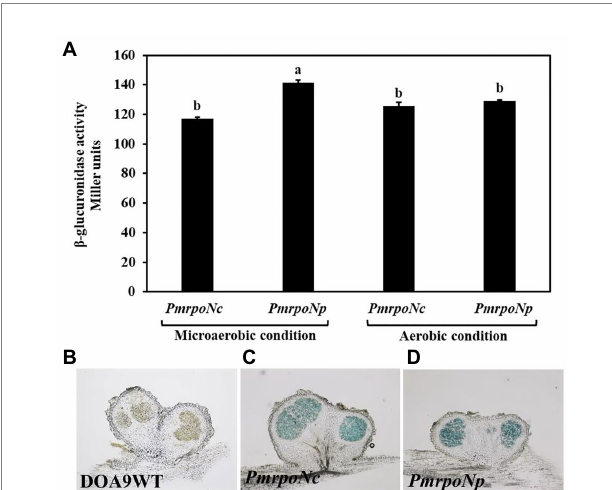
FIGURE 2 Expression of chromosomal and plasmid encoded rpoN under free- living and symbiotic conditions. PmrpoNc and PmrpoNp GusA reporter strains were grown under microaerobic and aerobic conditions and after 7 days of incubation, and β -glucuronidase activity (in Miller units) was determined. Data sets represent mean values of five replications, and statistically significant differences (ANOVA Tukey test; p < 0.01) are indicated (A) . β -glucuronidase activity in nodules of Aeschynomene americana plants inoculated with the WT and PmrpoNc and PmrpoNp GusA reporter strains at 14 dpi (B–D) . β -glucuronidase activity in nodule slices was determined by staining with X-gluc for 15